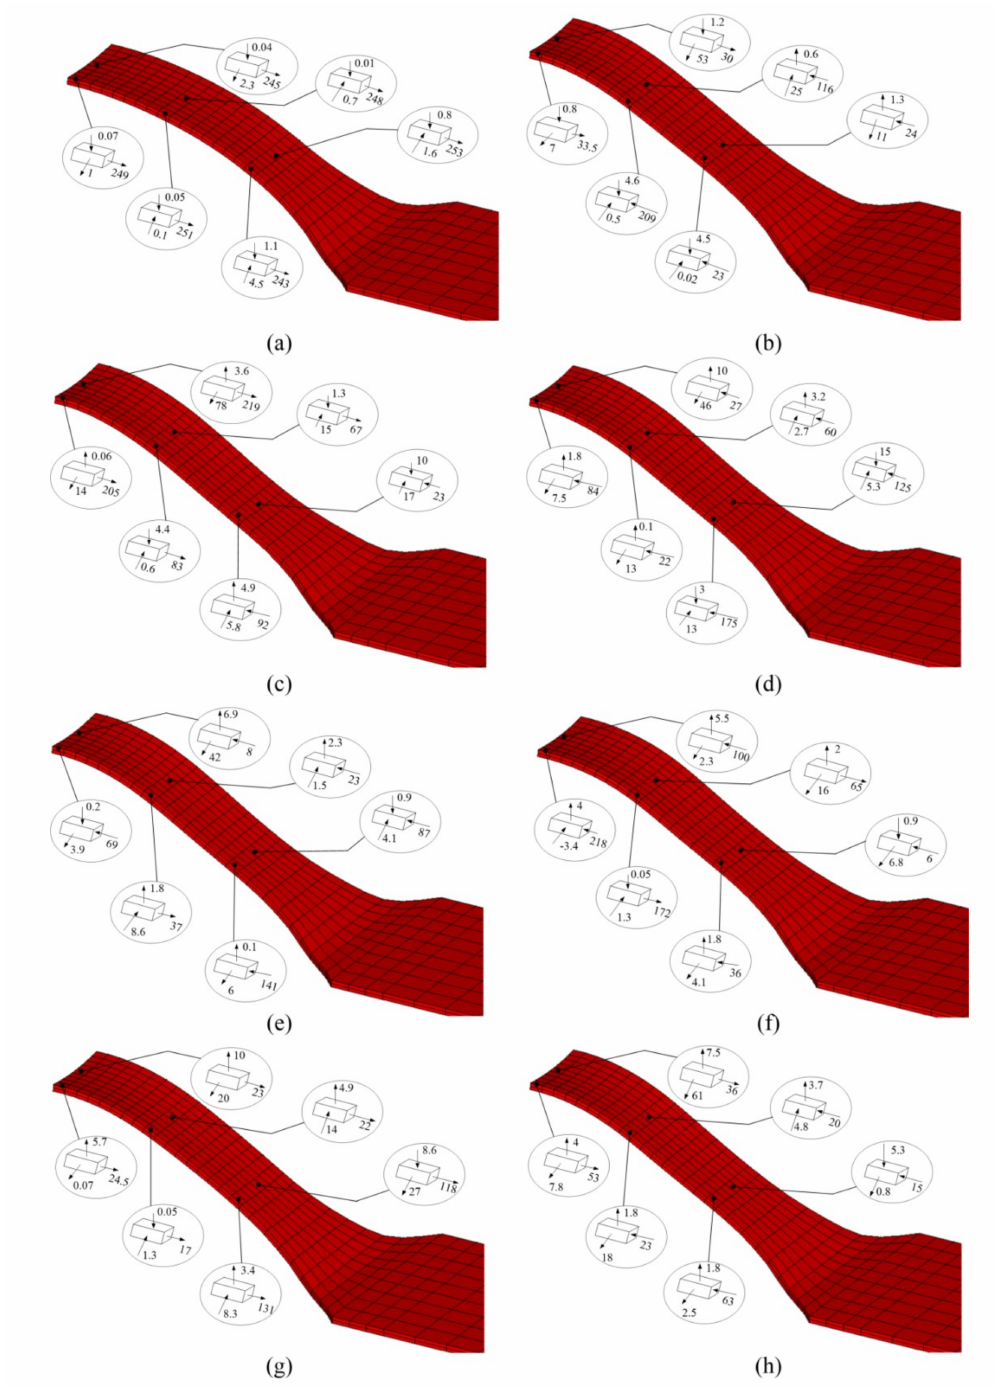
Figure 14. Stress and direction at different times: ( a ) 180 µ s, ( b ) 260 µ s, ( c ) 320 µ s, ( d ) 360 µ s, ( e ) 420 µ s, ( f ) 500 µ s, ( g ) 1000 µ s, and ( h ) 2000 µ